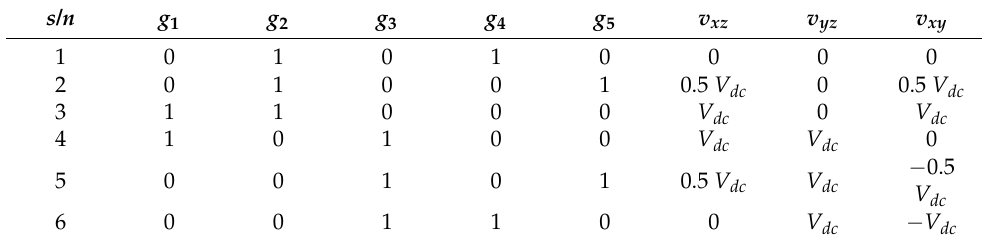
Table 1. Switching states and corresponding synthesized output voltages of 5-level switch-clamped